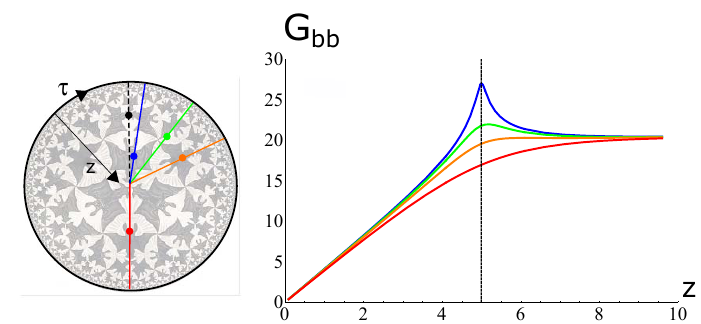
Figure 2 . Euclidean bulk-to-bulk two point function (2.17) at finite temperature ( β = 2 π , C = = 5) and the second bulk point at ( it, z ), as a function of z . 1 / 2), with one bulk point at ( t = 0 , z (cid:31) Blue: it = 0 . 1, Green: it = 0 . 5, Orange: it = 1, Red: it = π